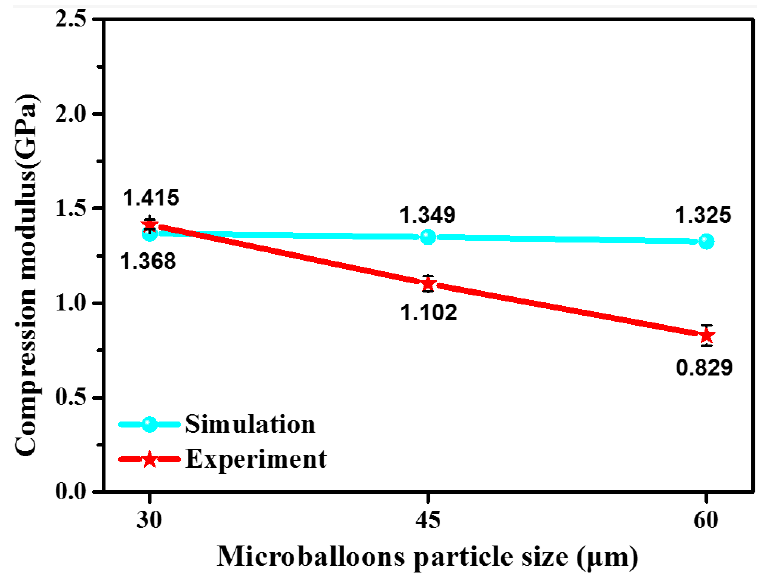
Figure 6. The simulation and experimental results of compression modulus for specimens with different microballoon types.